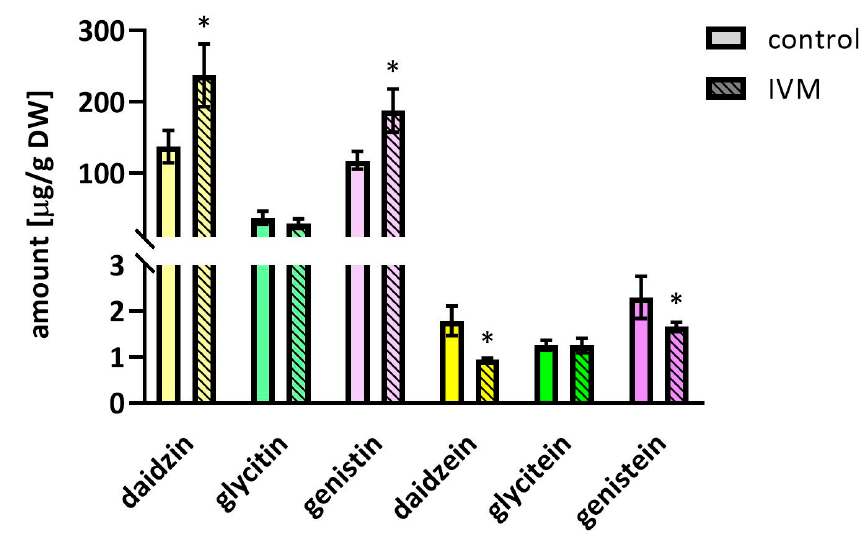
Figure 4. Concentration of isoflavones in dry seeds harvested after 42 days of the experiment. The final concentration of IVM added to the soil was 35 μ g/g of dry soil. Data are expressed as mean ± SD ( n = 6). * indicates statistically significant difference between treated and control plants.